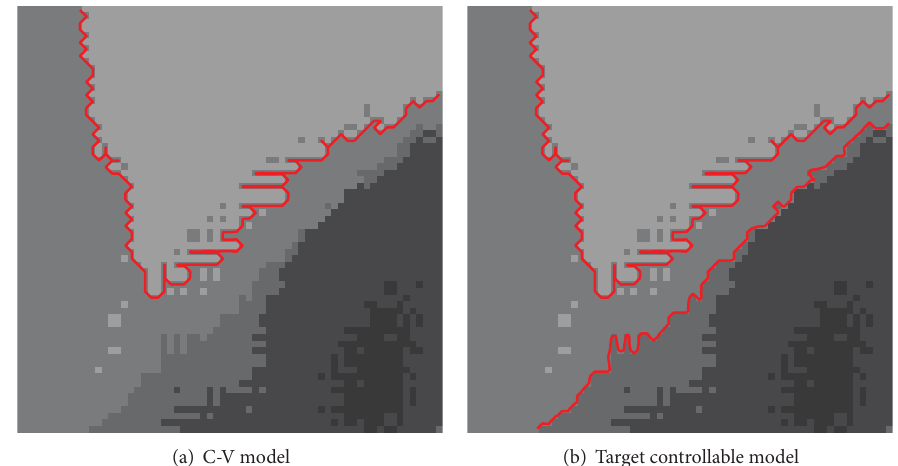
Figure 3: Special object segmentation.